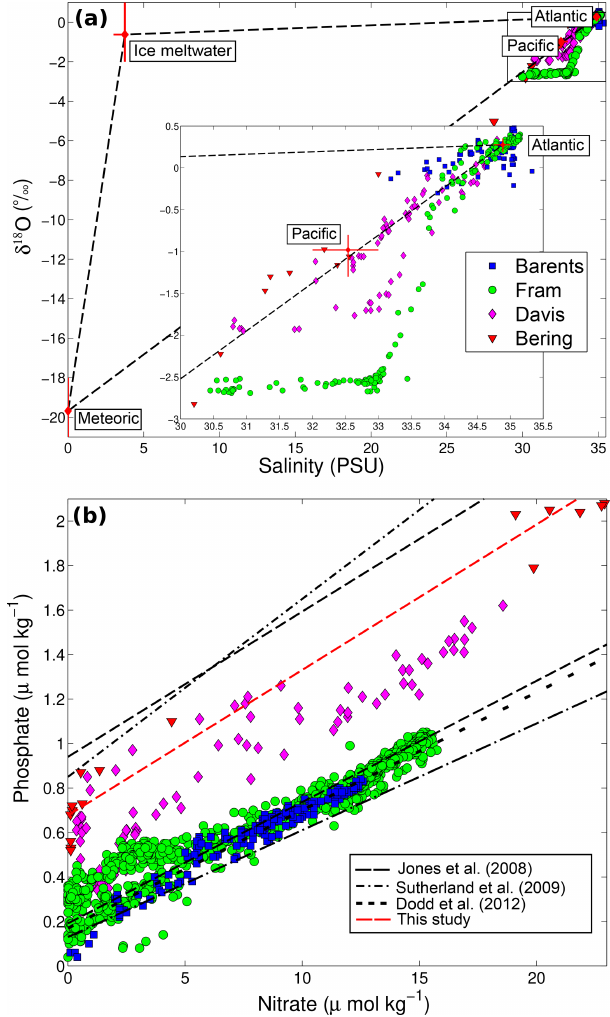
Figure 3. (a) Salinity– δ 18 O relationship for all samples used in this paper; mean literature end points ( ± standard deviation) are marked. Red crosses indicate the mean values of literature end points and black dashed lines the mixing lines between them. (b) Nutrient data for all samples used in this paper compared to the published N:P re- lationships of Jones et al. (2008), Dodd et al. (2012) and Sutherland et al. (2009). The dashed red line indicates a best fit to the Bering Strait nutrient data presented here. Symbols denoting the data from each section are the same in both panels. Note Dodd et al. (2012) uses the same Pacific relationship as Jones et al.